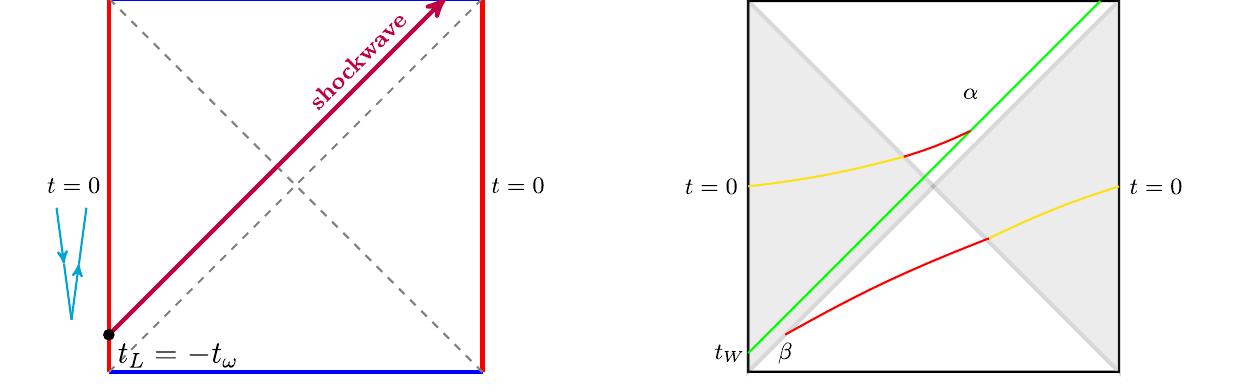
Fig. 9 The operator W L creates an infalling quantum at | t w | >> t ∗ , where t ∗ is the scrambling time. It undergoes a huge blue shift as it moves at the speed of light toward the horizon